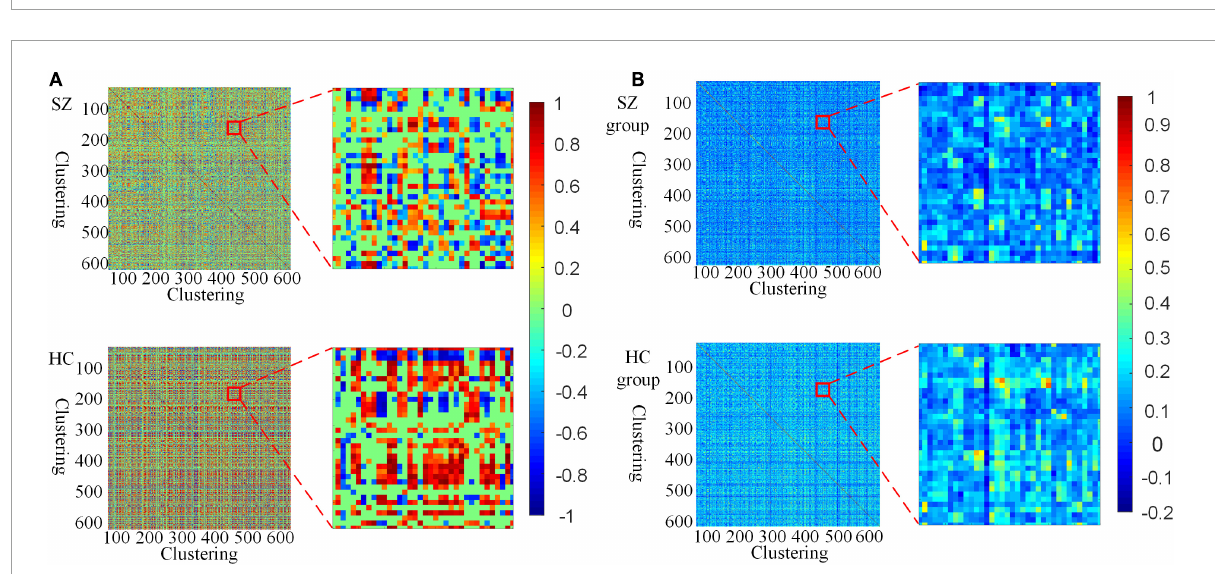
FIGURE4 Visualization of HFCN for SZ and HC ( L = 40, U = 600, λ HD = 0.5). (A) The HFCN and local details of the randomly selected SZ patient and HC. (B) The averaged HFCN and local details of SZ and HC groups.